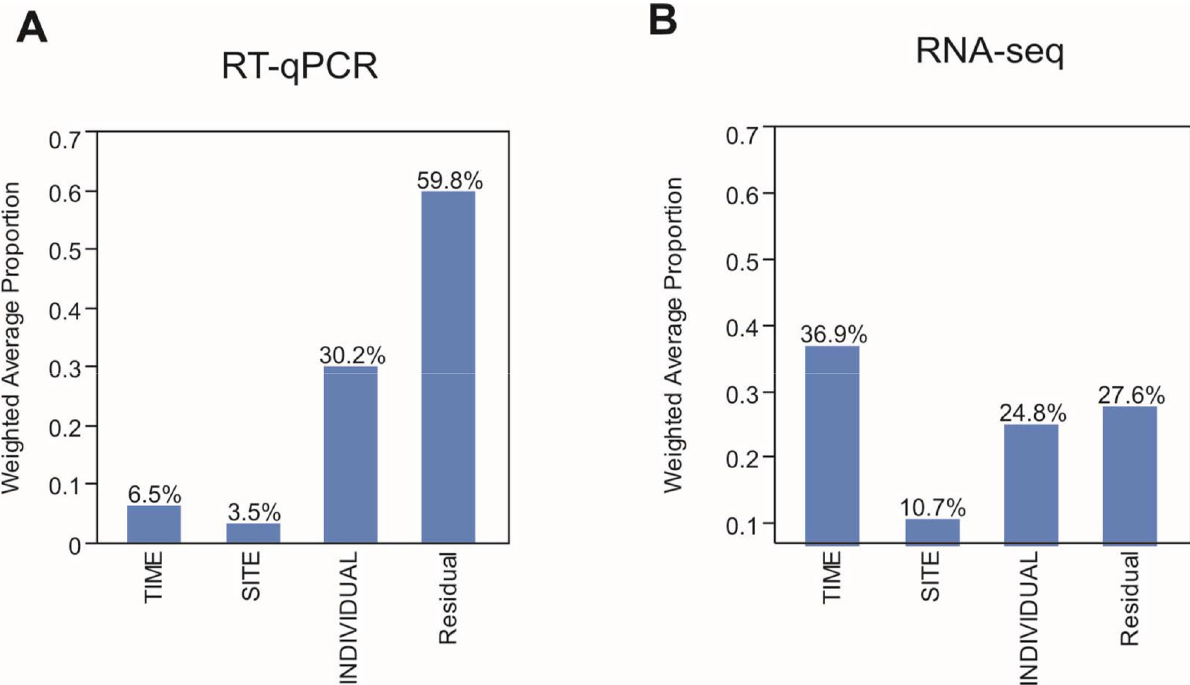
Fig 2. Principal component variance component analyses. Bar graphs shows the weighted average of the variance captured by the first five principal components among samples that is explained by Time (PRE, DAY5, DAY7, DAY9, Diagnosis, MTH4), Site (Cali, Buenaventura) and individual, indicating that most the variability is among individual for RT-qPCR (A) and Time (PRE and Diagnosis day) for RNASeq data set